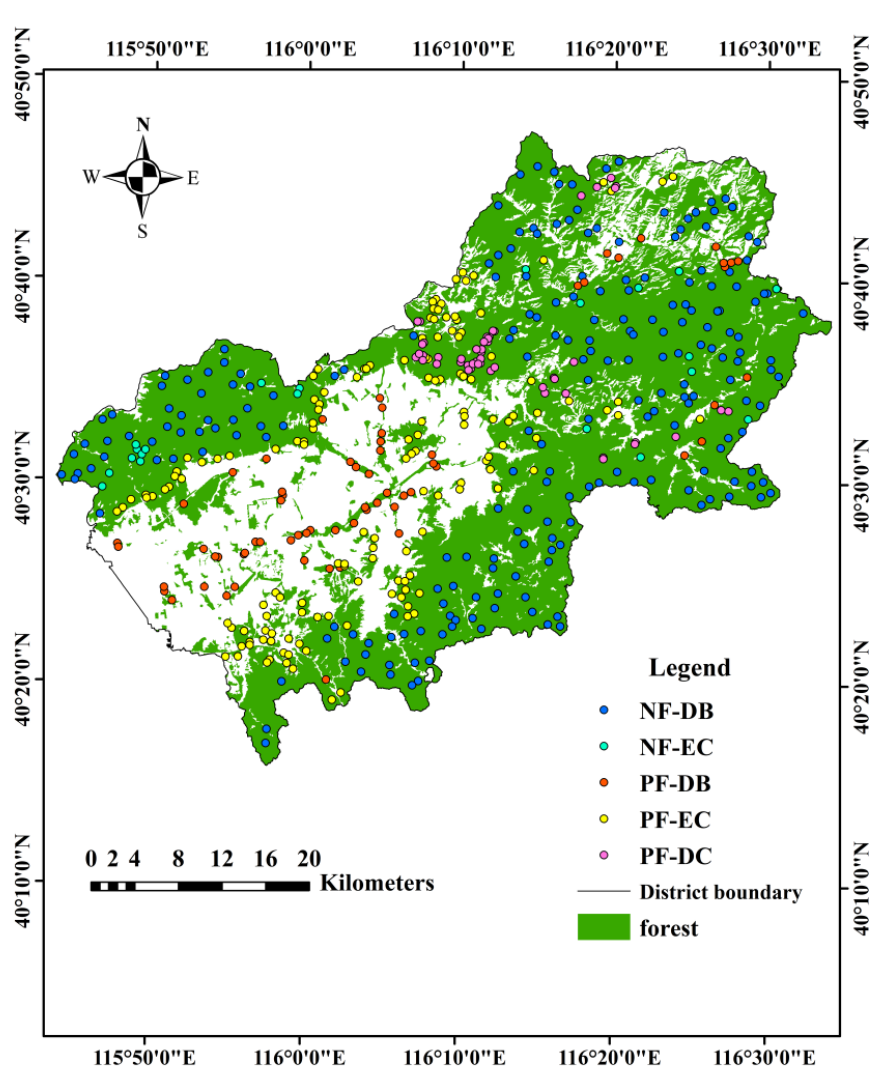
Figure 1. Study area and forest type samples NF-DB: natural deciduous broad-leaved forest; NF-EC: natural evergreen coniferous forest; PF-DB: deciduous broad-leaved plantation; PF-EC: evergreen coniferous plantation; PF-DC: deciduous coniferous plantation.